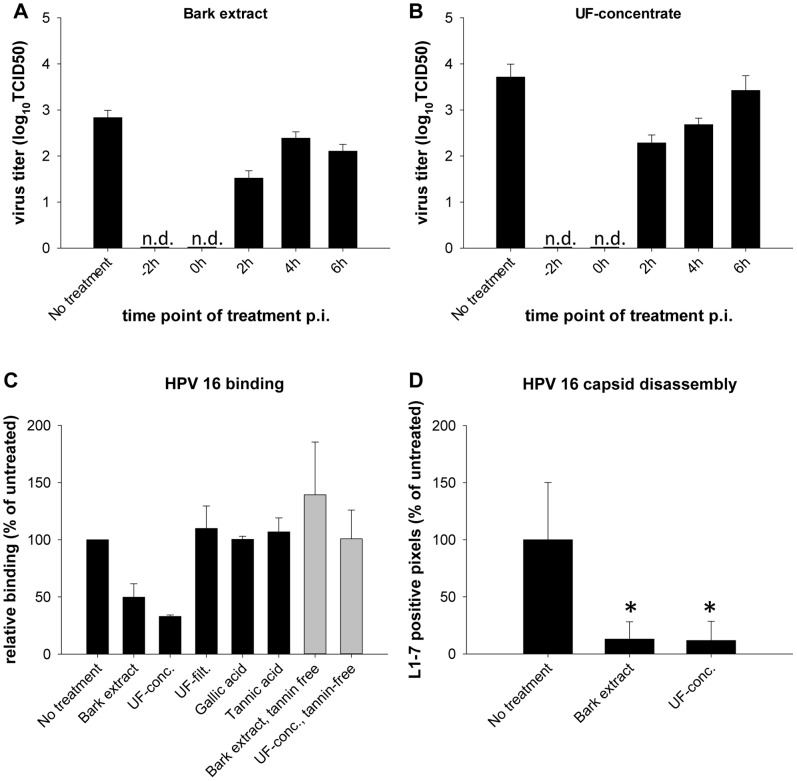
Effect on different IAV and HPV life cycle steps.(A–B) Step of the IAV life cycle affected. A549 cells were infected with pandemic H1N1 (MOI 0.1), and treated with 50 µg/ml of bark extract (A) or 10 µg/ml of UF-concentrate (B) starting 2 h before infection or 0, 2, 4 or 6 h after infection. TCID50s were determined 24 h post infection. (C) Effect on HPV attachment. HaCaT cells preincubated for 1 h with the original (black bars) or tannin-free (grey bars) extracts or DMSO and infected for 15 min with 500 HPV pseudovirions per cell were washed five times and collected in SDS sample buffer for Western blotting. Cell-bound HPV16 particles were stained with anti-L1 antibody and relative band intensities to the β-actin band were quantified densitometrically. (D) Effect on HPV capsid disassembly. HaCaT cells were treated with 20 µg/ml of the extracts for 1 h before HPV 16 pseudovirion infection for 7 h followed by fixation and staining with mouse anti-L1-7 antibody. L1-7 recognizes an epitope located inside of the pseudovirion capsid accessible after uncoating. Fluorescence of L1-7-positive pixels was normalized to the cell nucleus signal (Hoechst staining) and expressed as % of untreated. n.d., not detectable or TCID50<1. * significant difference (p<0.05) as compared to “No treatment”.